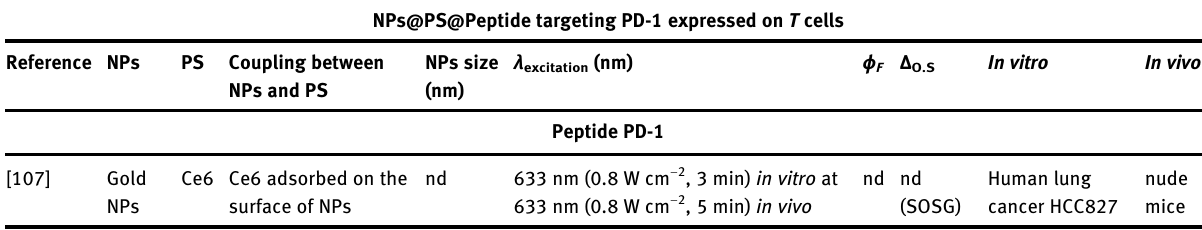
Table  : The summary of NPs conjugated with PSs and peptides targeting PD-  in terms of different